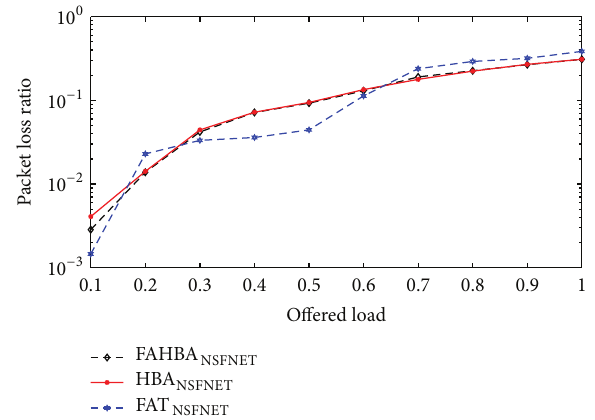
Figure 10: Packet loss ratio versus offered load.